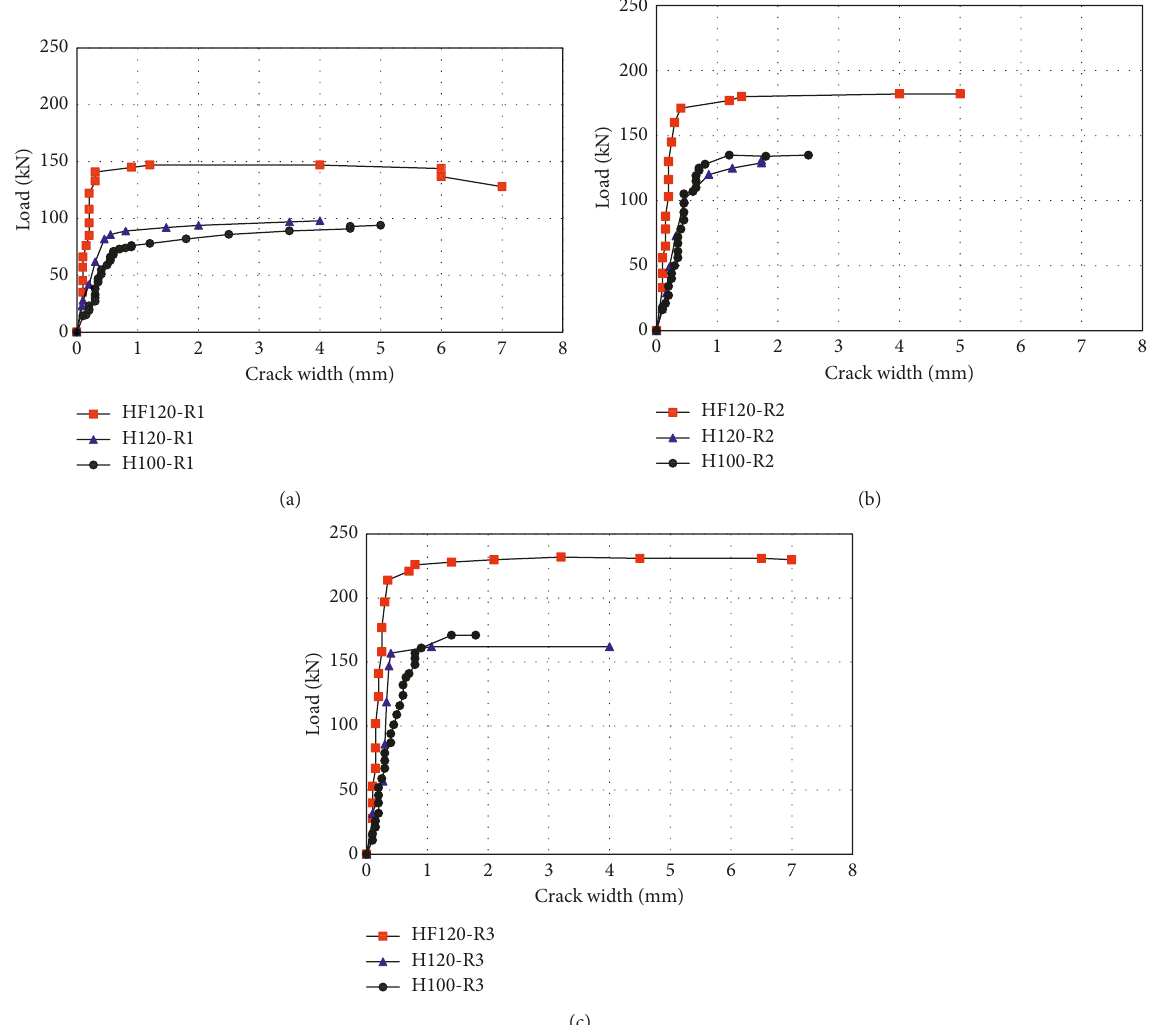
Figure 7: Load and crack width relationship. (a) Rebar ratio of 0.98%. (b) Rebar ratio of 1.47%. (c) Rebar ratio of 1.97%.